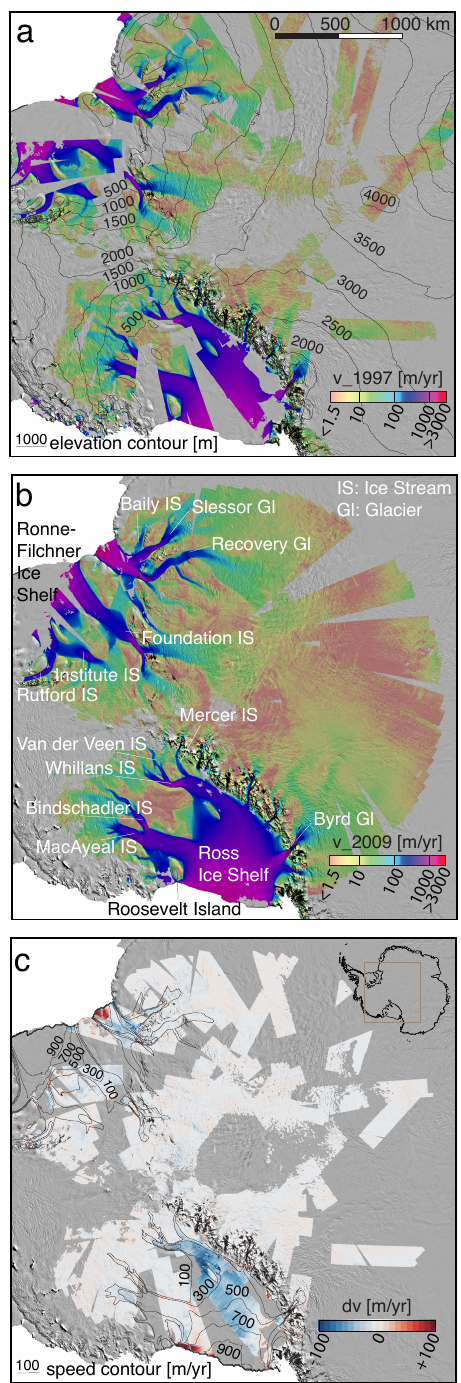
Fig. 1. Ice surface velocity maps for Central Antarctica for 1997 (a) and 2009 (b) overlaid on MOA. (c) shows the difference in speed d v (2009–1997) for the entire region. Blue tones indicate a deceler- ation, red tones an acceleration. The two dark red regions on the ice shelf edges (Ross Ice Shelf near Roosevelt Island and Filchner Ice Shelf) indicate pre-calving